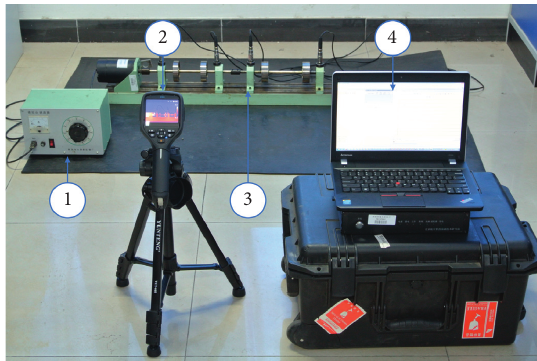
Figure 4: Experimental setup. 1, variable speed controller; 2, thermal camera; 3, rotor test stand; 4, GUI in